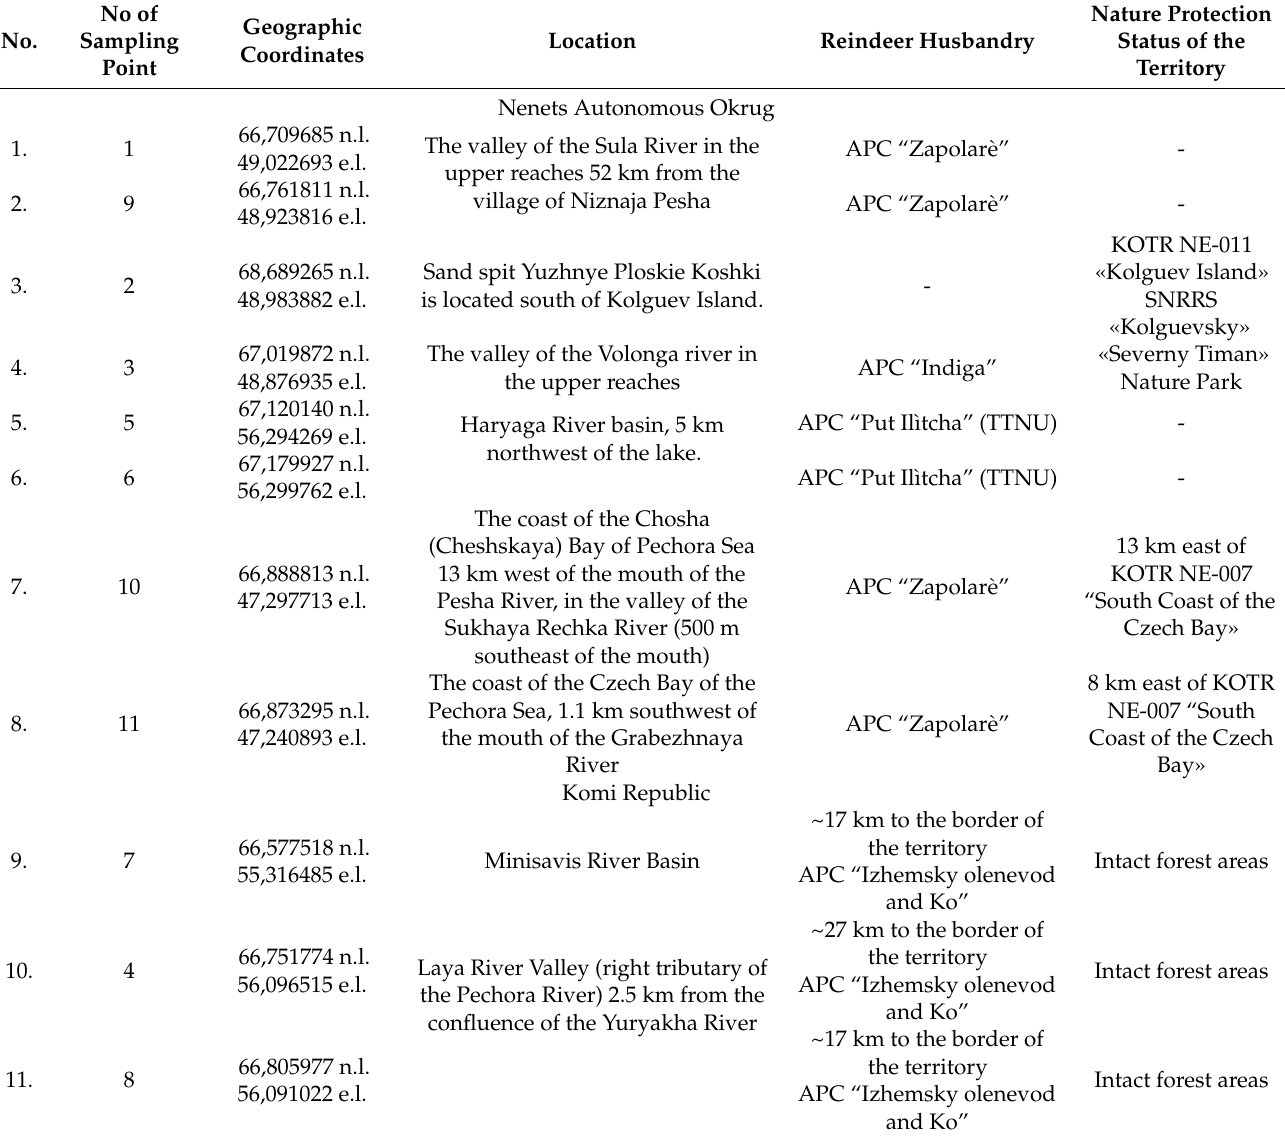
Table 1. Data on sampling